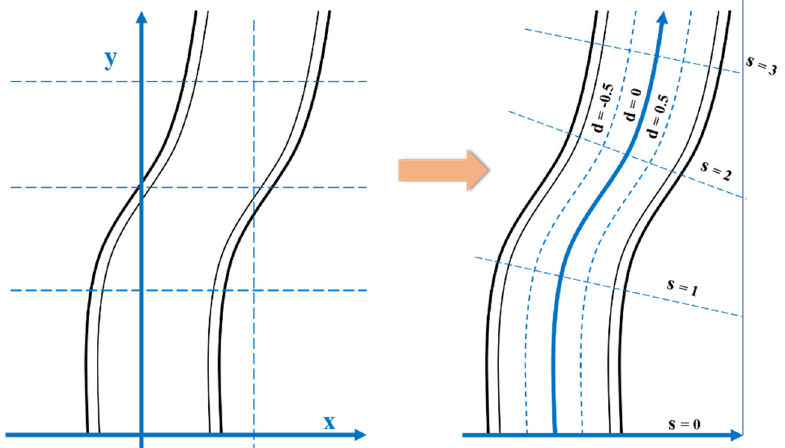
Figure 14. Converting Cartesian coordinate system to the Frenet coordinate system.